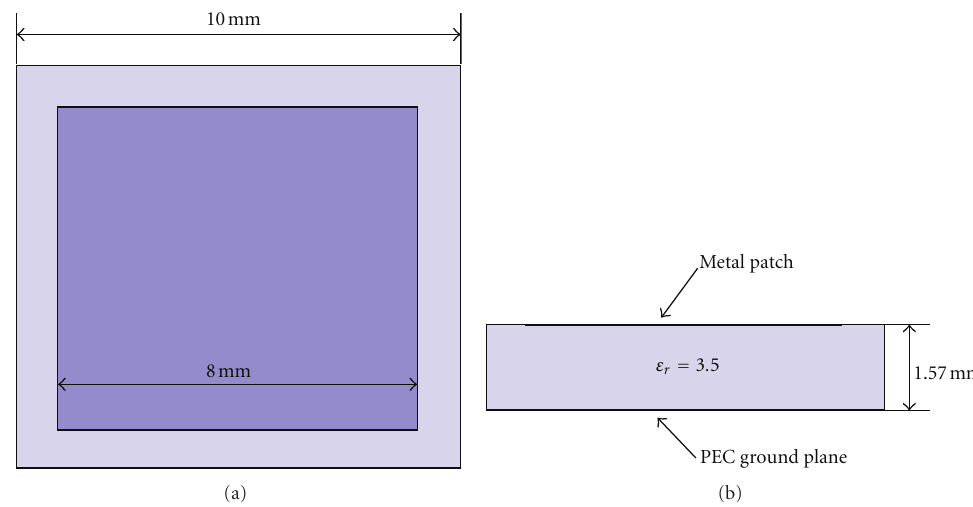
Figure 6: AMC unit cell consisting of a square PEC patch on a dielectric substrate with relative permittivity 3.5. (a) Top view. (b) Side view.